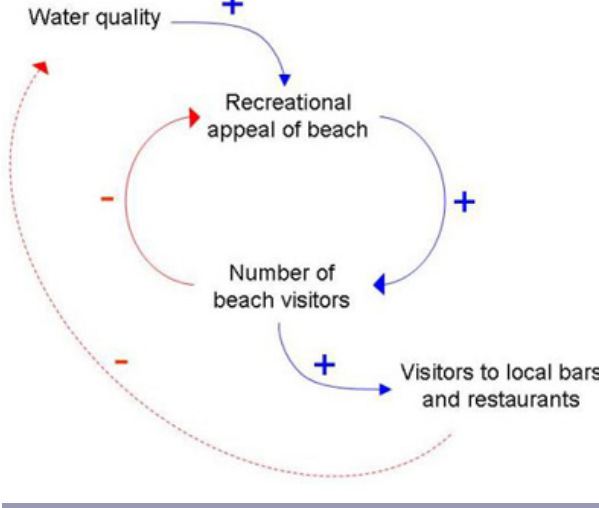
Fig. 3 . Feedback loop in beach visitors. Even if